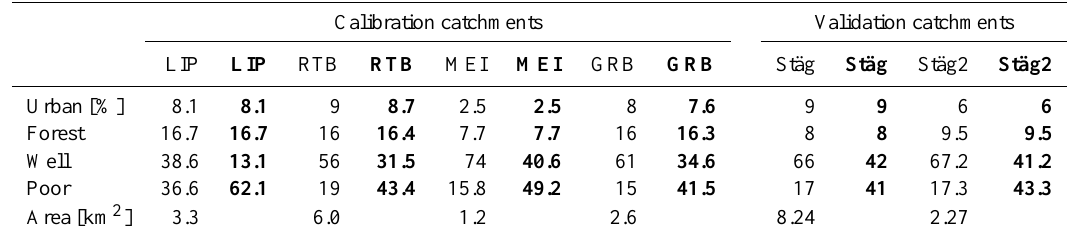
Table 2. Areal fraction of each hydrological response unit (HRU) on the total catchment area in [%] – roman font = model Version 2, bold font = model Version